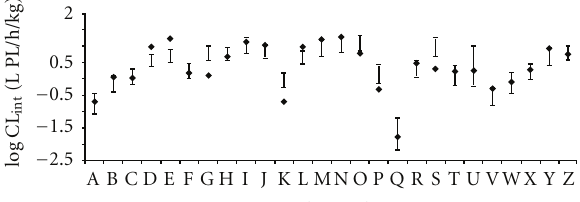
Figure 2: Experimental and predicted values of log CL int for 26 VOCs. The horizontal bars represent the QPPR predicted LMCI and UMCI, the symbols represent the experimental data.